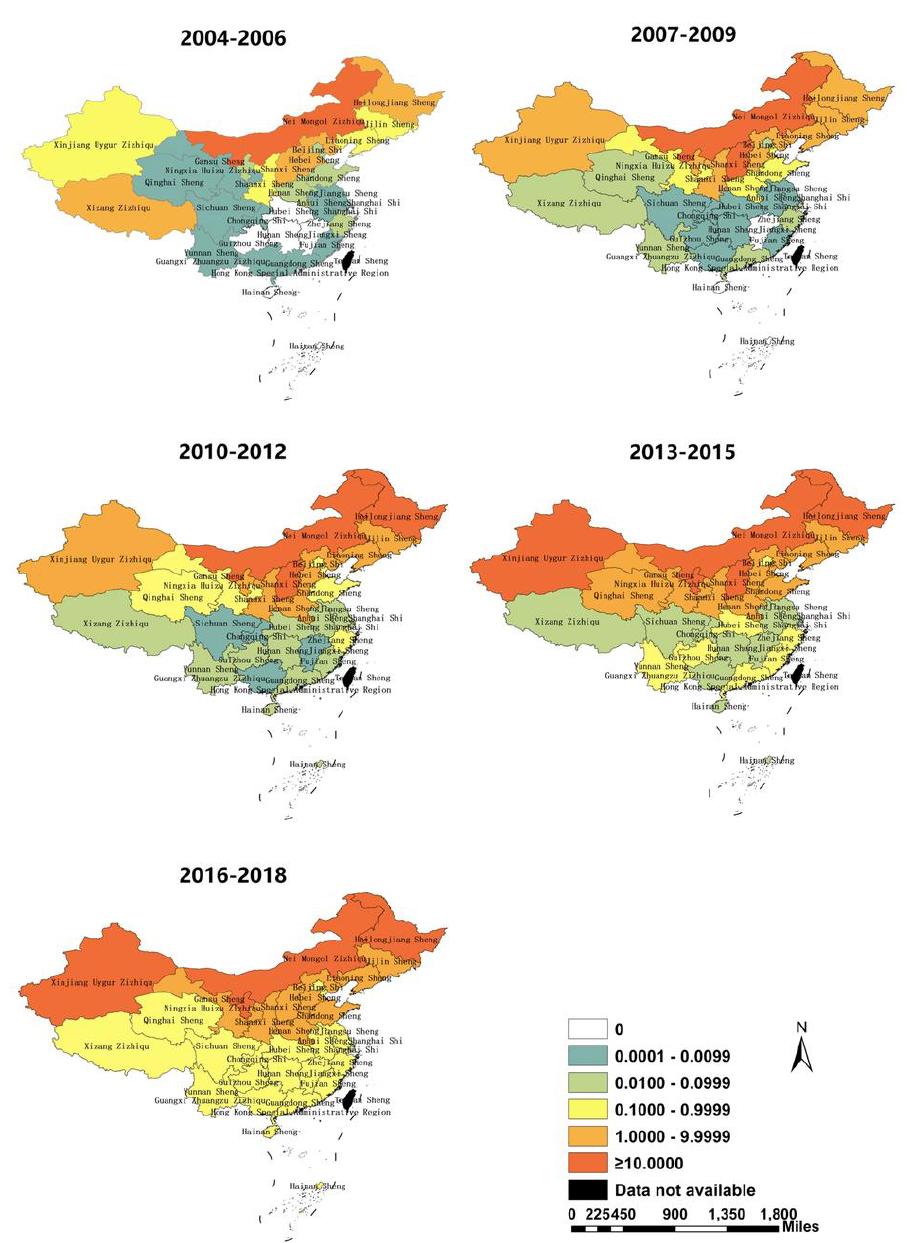
Figure 2. Annual incidence distribution of brucellosis in mainland China in 2004–2018 (by 3 year period).